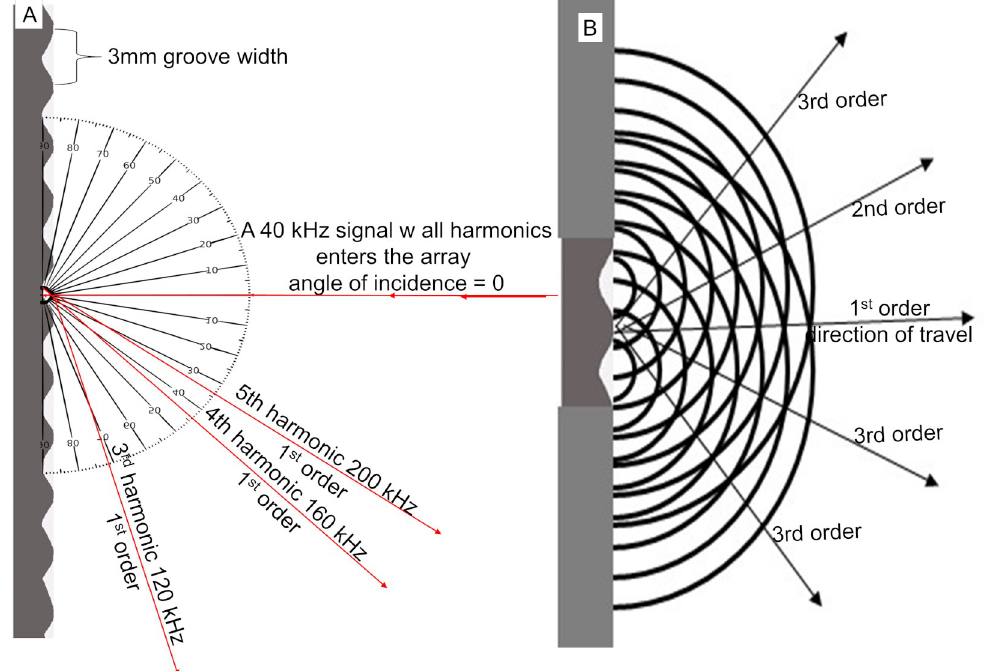
Fig 2. Sound waves response to groove arrays. (A) The direction of travel varies for different wavelengths. When a 40kHz harmonic series contacts a 3mm width groove array, the harmonics have different 1 st order exit angles which can be calculated in relation to the 40 kHz fundamental and the angle of incidence is normal (= 0˚). Because the wavelengths of the first two harmonics (40 and 80 kHz wavelengths = 8.575mm and 4.2875mm) are too large to diffract from a 3mm width groove, diffraction occurs for all harmonics above the 3 rd harmonic out of each groove. For clarity we only show the response from a single groove, but this would result from every groove. (B) Waves expanding from the grooves contact each other in organized patterns. As the number of grooves increases these patterns multiply. For clarity we show the pattern of interaction from just two grooves.